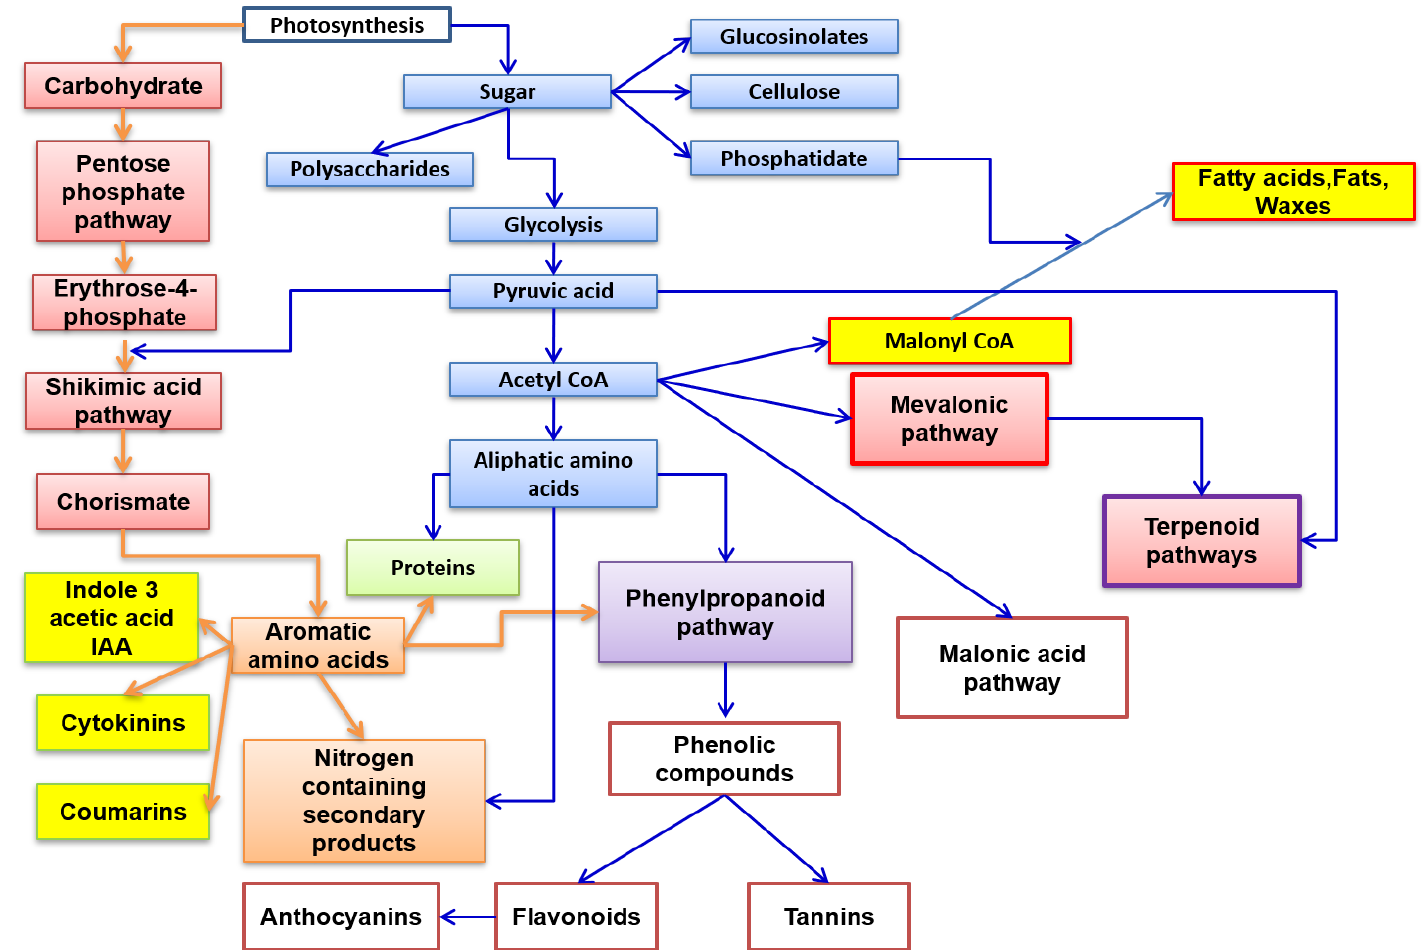
Figure 1. Principal biosynthetic pathways of major secondary metabolite plants ’ classes.